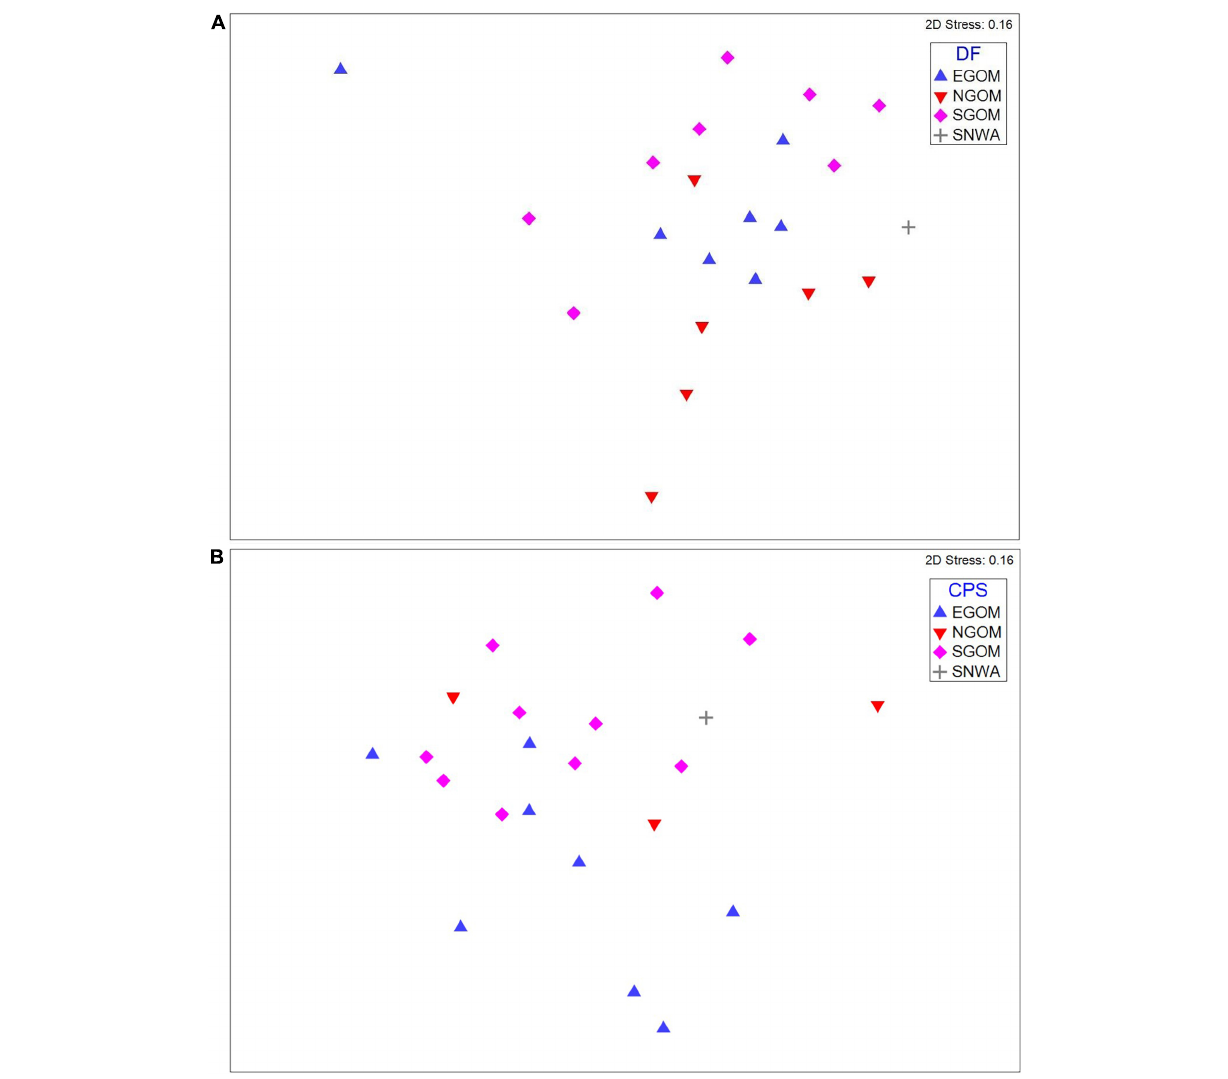
FIGURE 2 | nMDS plots for (A) meiofauna presence-absence assemblages and (B) nematode square-root abundance assemblages showing evidence for moderate clustering (indicated by points occupying similar space in nMDS plots) by foraging region assignments (symbols). DF, Discriminant Function assignments; CPS, Continuous Probability Surface assignments; EGOM, Eastern Gulf of Mexico; NGOM, Northern Gulf of Mexico; SGOM, Southern Gulf of Mexico; SNWA, Subtropical Northwest